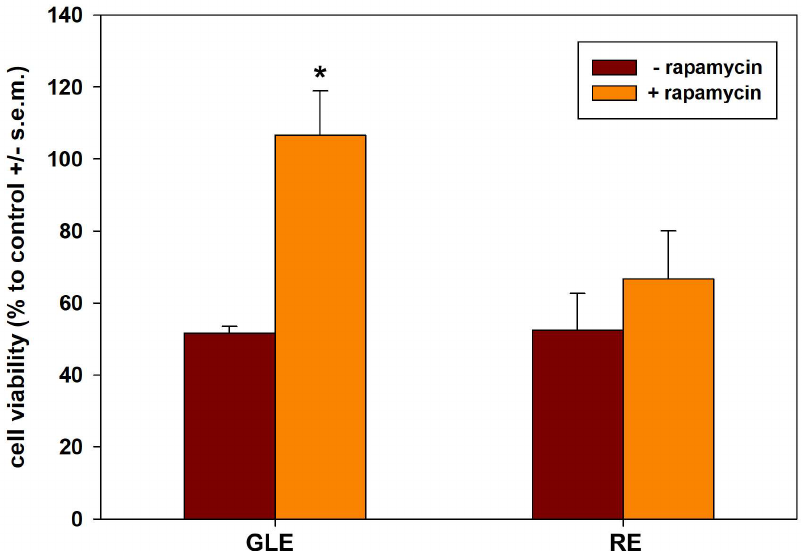
Figure 11. Histograms showing the effect exerted by 1 nM rapamycin co-treatment on GLE- or RE- induced decrease in HepG2 cell viability after 24 h of exposure. The error bars correspond to the standard error of the mean (s.e.m.) of three independent measurements. * normality test vs. control passed.